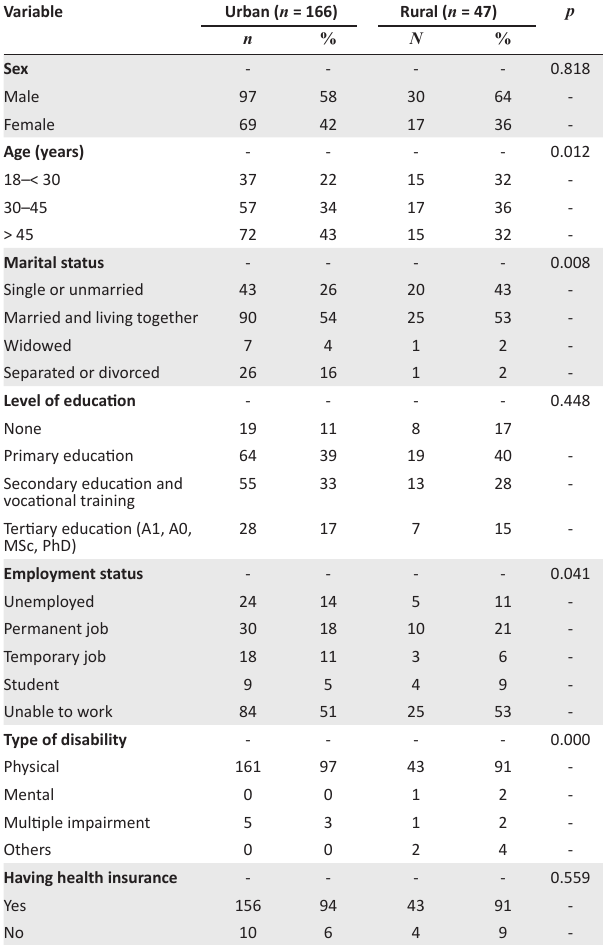
TABLE 3a: P -values for demographic characteristics by source of funding (public versus semiprivate).